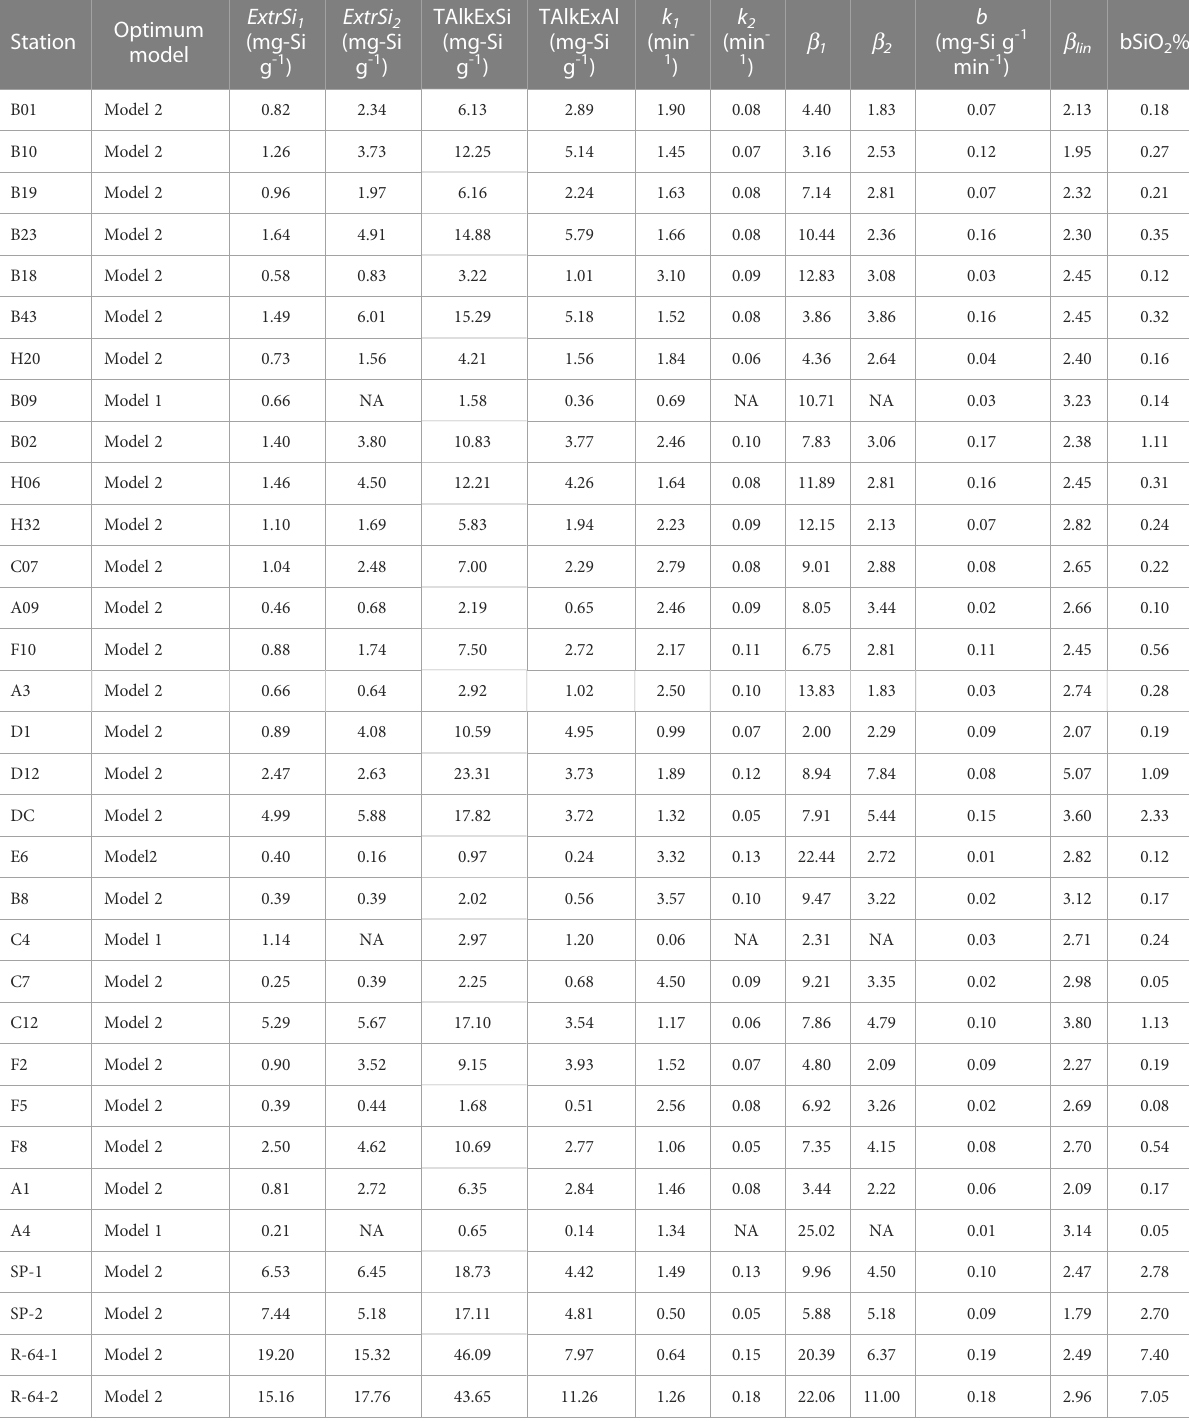
TABLE 5 Parameters from the Si and Al continuous dissolution (Si/Al method) with 0.5 M NaOH (1 h digestion).